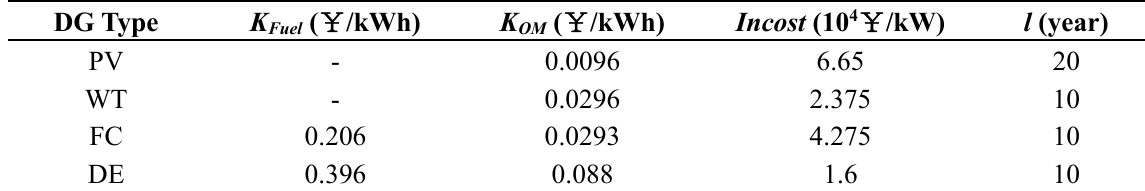
Table 3. Cost parameters of DGs.